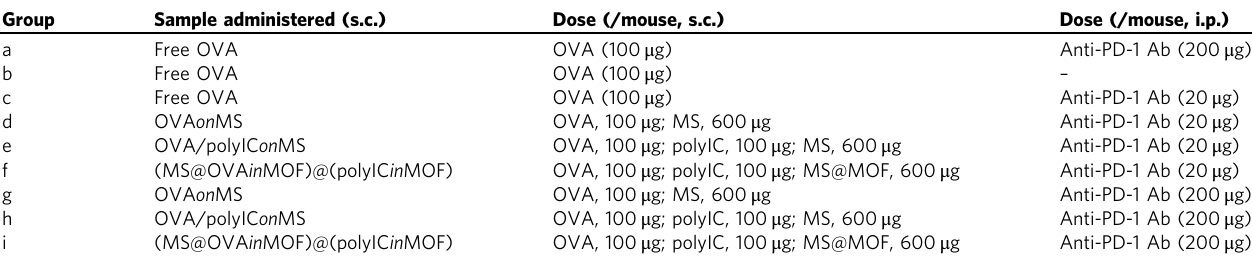
Table 1 Experimental parameters for combination immunotherapy of MOF-gated MS vaccination and PD-1 blockade (Figs. 5, 6 and S31 – S34). Sample administered